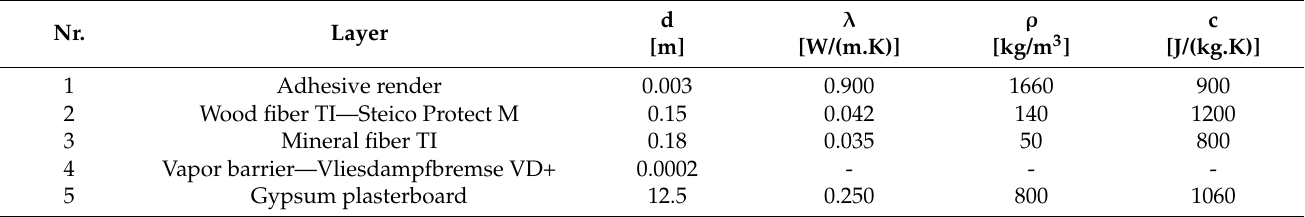
Table 1. Main characteristics of the integrated